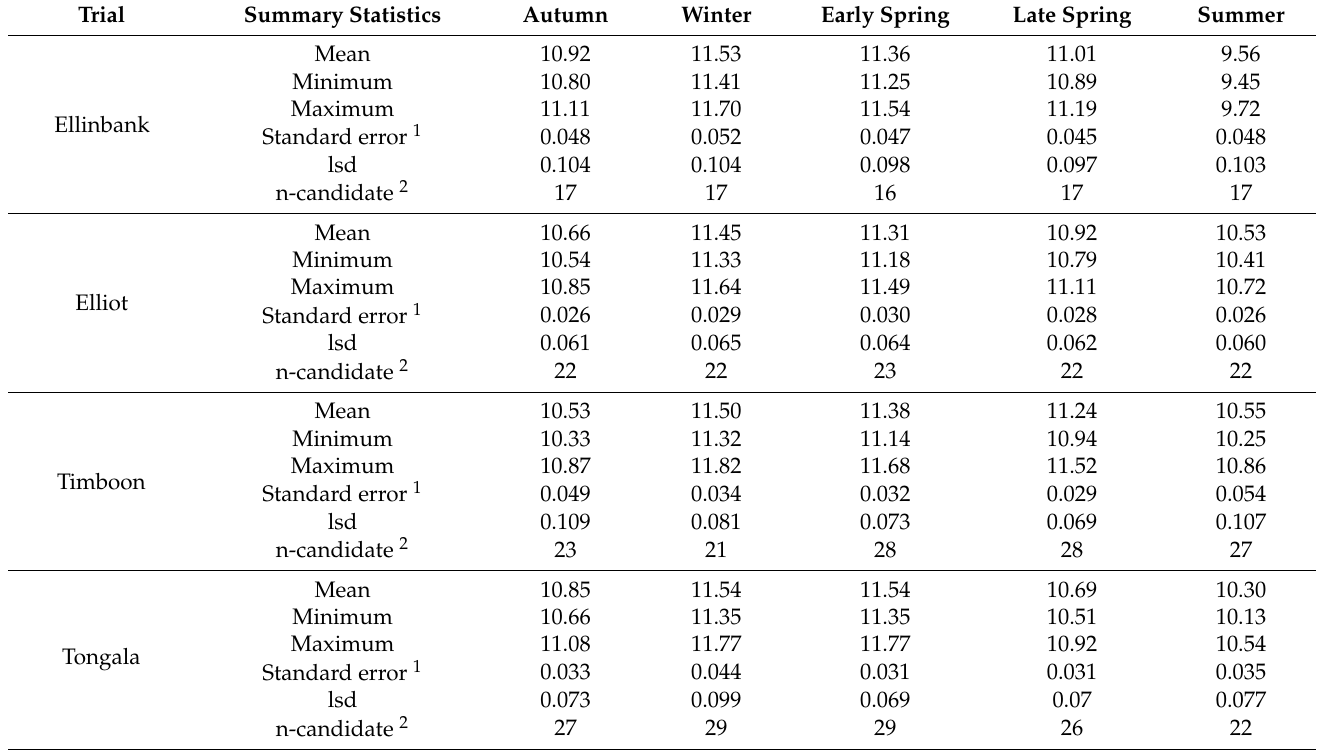
Table A2. Summary statistics and lsd values for metabolisable energy for each season derived from 3 years of trial